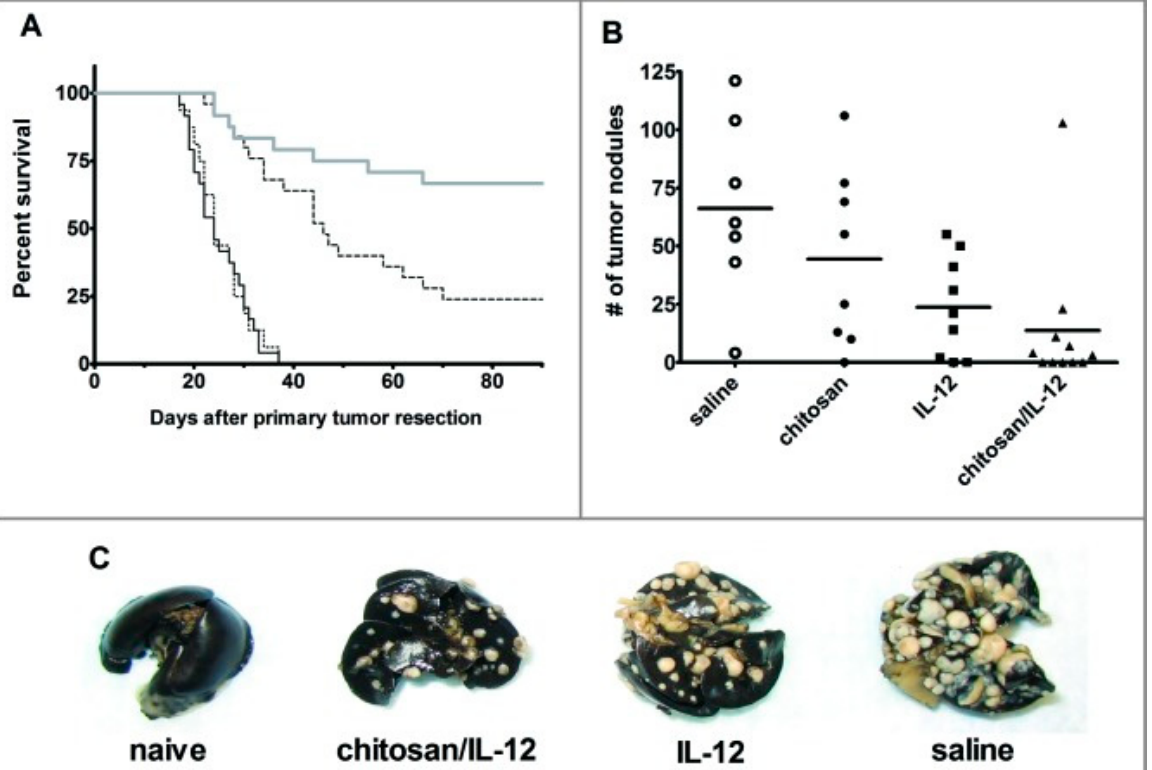
Figure 5. Neoadjuvant chitosan/IL-12 treatment enhances survival and limits distant site metastasis of breast cancer. ( A ) BALB/c mice implanted with 4T1 mammary adenocarcinoma were intratumorally administered chitosan/IL-12 (2 μ g) (thick gray line), chitosan alone (dotted line), IL-12 alone (dashed line), or saline (solid black) line on the 6th, 9th, and 12th post-implantation days. On the 15th day, implanted primary tumors were resected and mice were followed onwards for symptoms of lung metastasis. Mice manifesting signs of severe distress were euthanized to assess the presence of meta- static lesions. Surviving mice were followed for at least 90 days post-resection of the primary tumor. ( B ) In a different study, mice were euthanized after five weeks of primary tumor resection and the number of metastatic nodules in the lungs of mice from four different treatment arms was enumerated using a stereomicroscope following infusion of the removed lungs with India ink. ( C ) The lungs images of control mice and mice treated with chitosan/IL-12, free IL-12, or saline at five weeks post-resection. This figure is adapted from Vo et al. (2015) [138], non-commercial uses of this study do